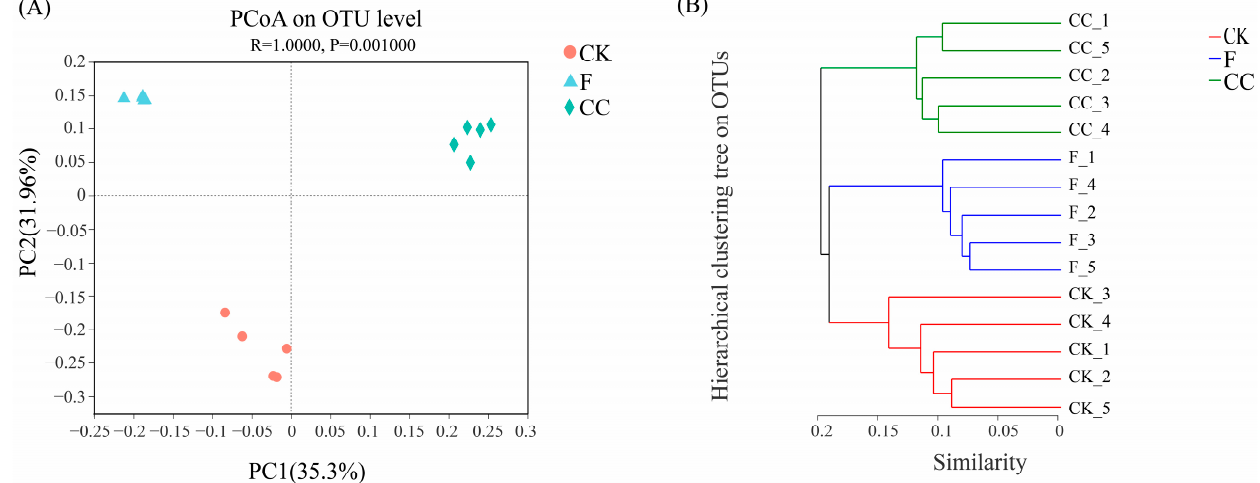
Figure 3. ( A ) Principal coordinate analysis (PCoA) and ( B ) hierarchical cluster tree of fungal community in tea nursery soil samples.